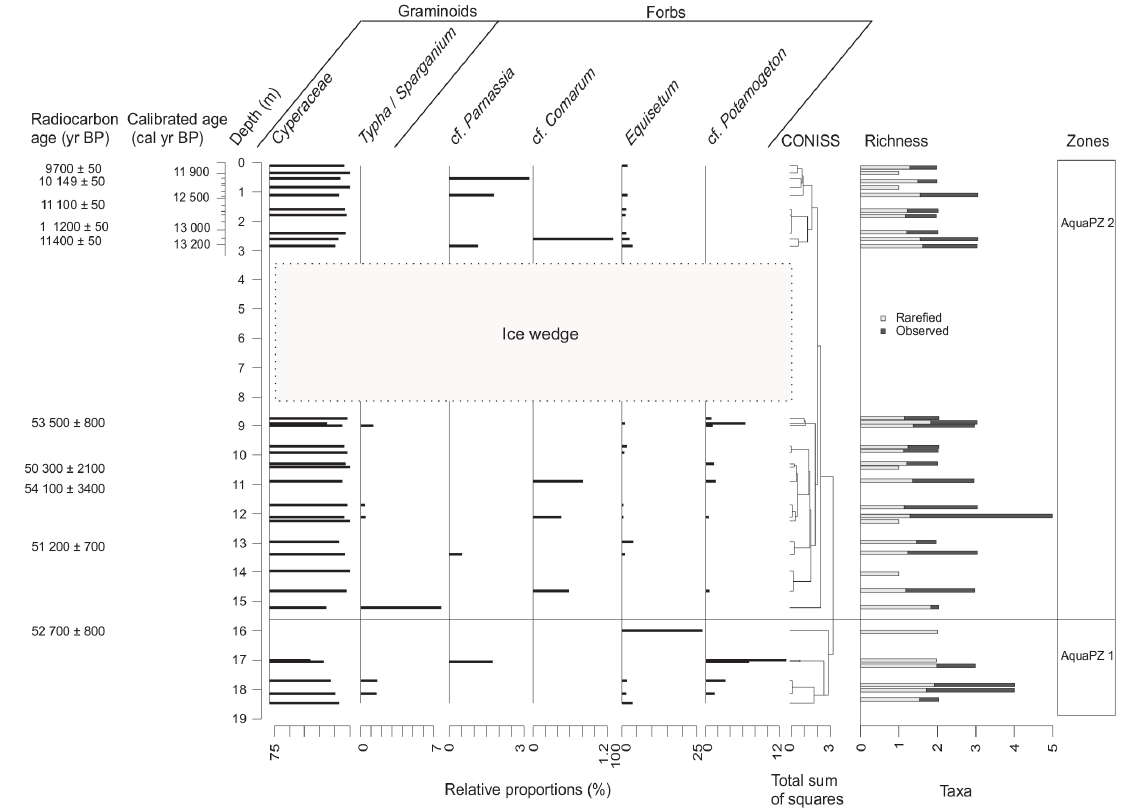
Figure 8. Stratigram of swamp and aquatic pollen and/or spores with relative proportions of the taxa in each sample as horizontal bars and CONISS dendrogram. The grey area indicates the ice wedge where no samples were taken. Uncalibrated radiocarbon ages are given with standard error in years before present (yrBP) and calibrated ages from the age–depth model in calendar years before present (calyrBP). The horizontal line indicates the border between the palynological zones. Scaling is taxon-specific for better visibility of low